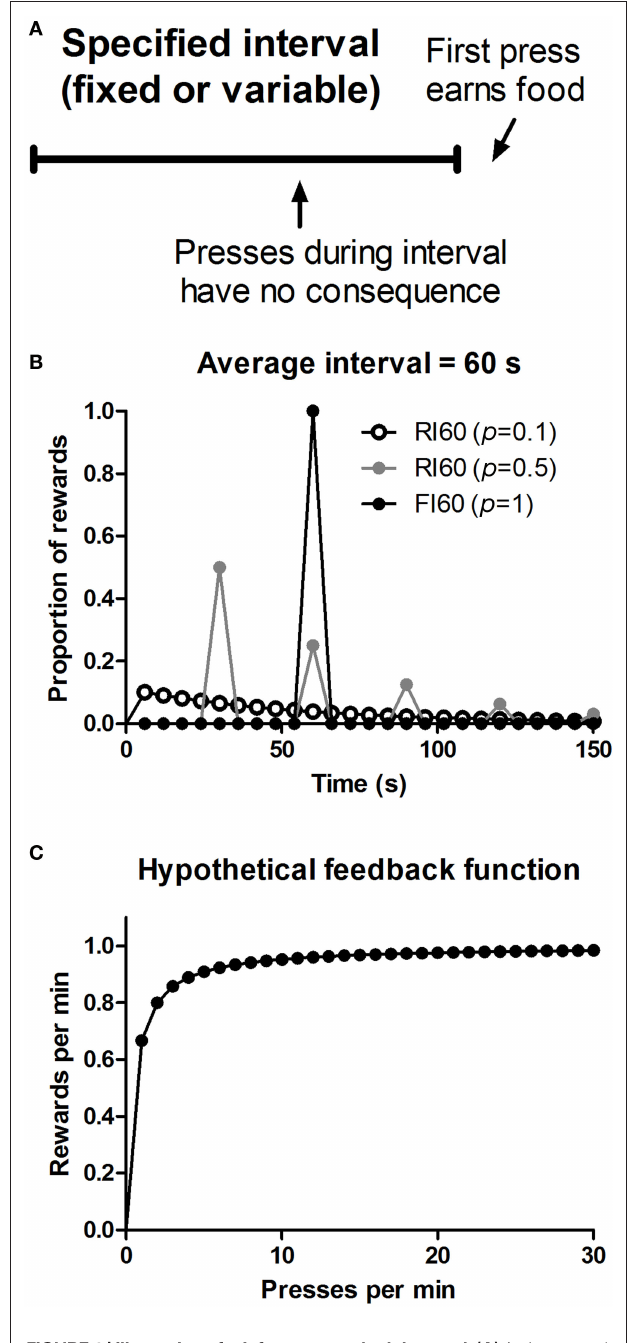
FIgure 1 | Illustration of reinforcement schedules used. (A) Action-reward contingency in interval schedules of reinforcement. (B) Distribution of when rewards first become available to be earned by lever pressing on three different types of interval schedules. p = 0.1, probability of reward for the first press after every 6 s; p = 0.5, probability of reward for the first press after every 30 s; p = 1, probability of reward for the first press after every 60 s. (C) Hypothetical feedback function of when the average scheduled interval is 60 s, based on the equation: r = 1/[ t + 0.5(1/ B )], where r is the rate of reward, t is the scheduled interval, and B is the rate of lever pressing (Baum,